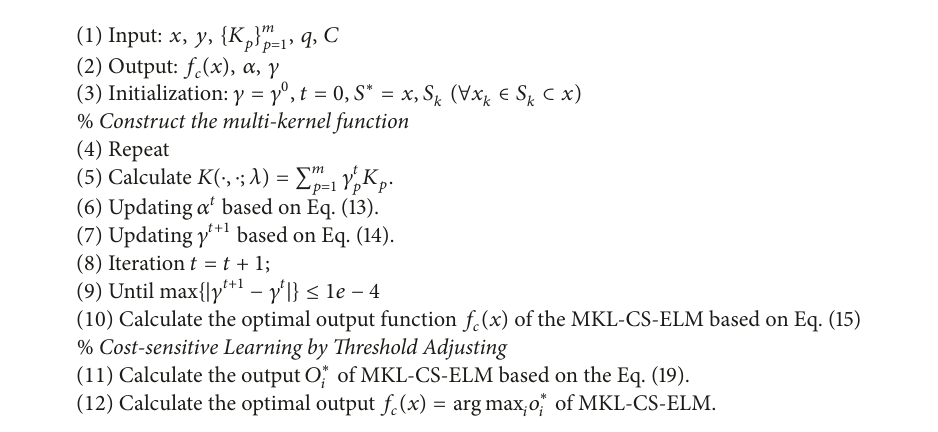
Algorithm 2: Threshold adjusting